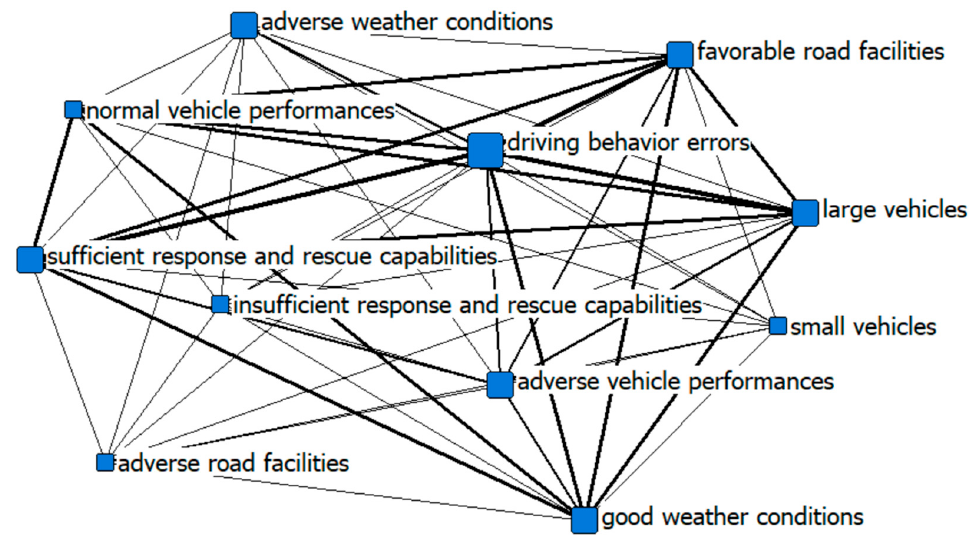
Figure 2. The social network analysis of major road accidents.